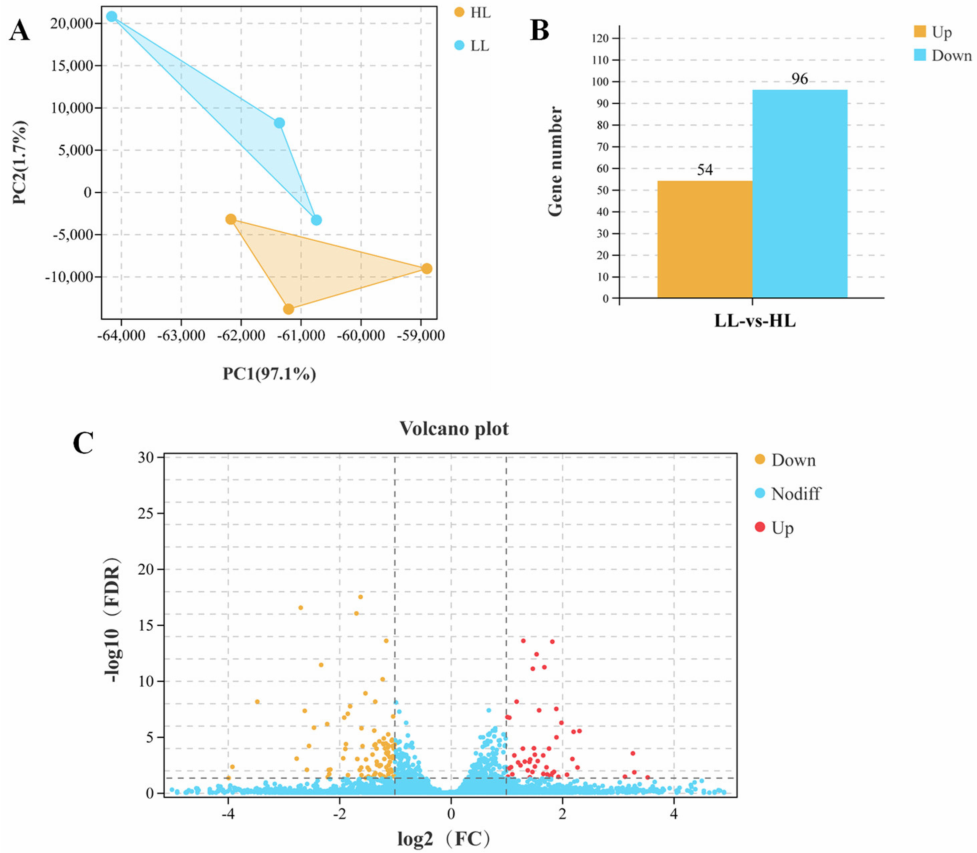
Figure 3. Differently expressed genes (DEGs) in the liver of M. salmoides between the low-density group (LL) and the high-density group (HL). ( A ) The correlation of samples between the LL group and the HL group. ( B ) The number of DEGs in the liver between the LL and HL groups. ( C ) Volcano plot of DEGs between the LL group and the HL